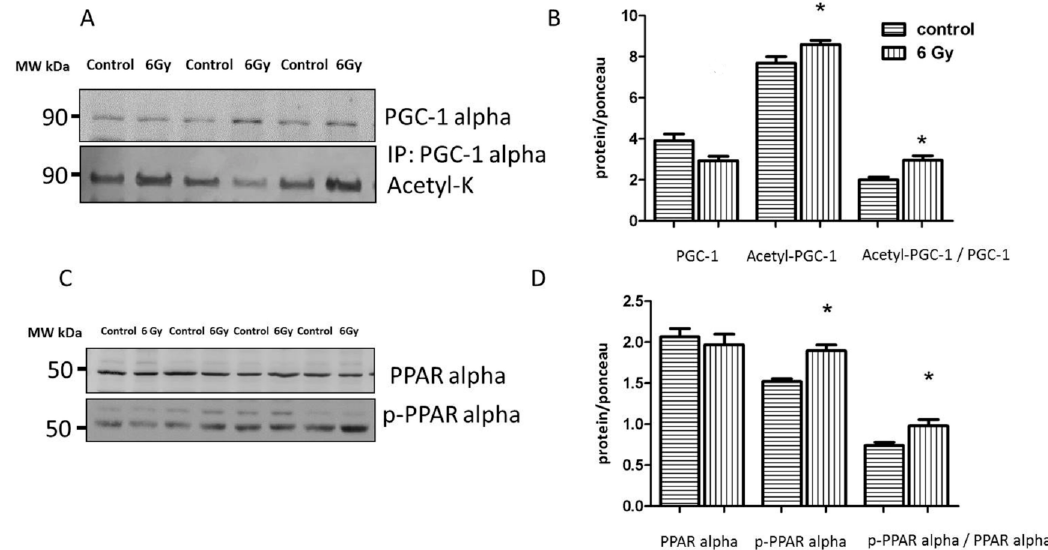
Figure 8. Analysis of the cardiac PGC-1 and PPAR alpha protein expression. Immunoblot analysis of total PGC1, and acetylated form (inactive) in whole heart lysate is shown ( A ). The columns represent the average ratios of relative protein expression in control and irradiated samples. The error bars represent standard error of the mean ( ± SEM) (t-test; * p < 0.05; n = 3) ( B ). Immunoblot analysis of total and phospho-PPAR alpha (Ser12) in whole heart lysate samples is shown ( C ). The amount of the total protein was measured by Ponceau S staining for an accurate comparison between the groups. The columns represent the average ratios of relative protein expression in control and irradiated samples after background correction ( D ). The error bars represent standard error of the mean ( ± SEM) (t-test; * p < 0.05; n = 4).